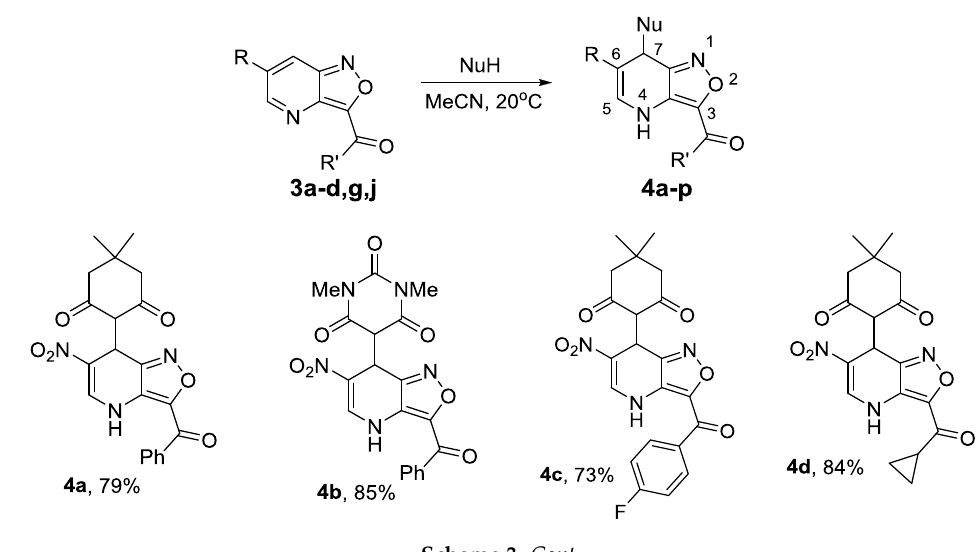
Figure 3. General view of 3b in crystal. Anisotropic displacement parameters for non-hydrogen atoms are drawn at 50%